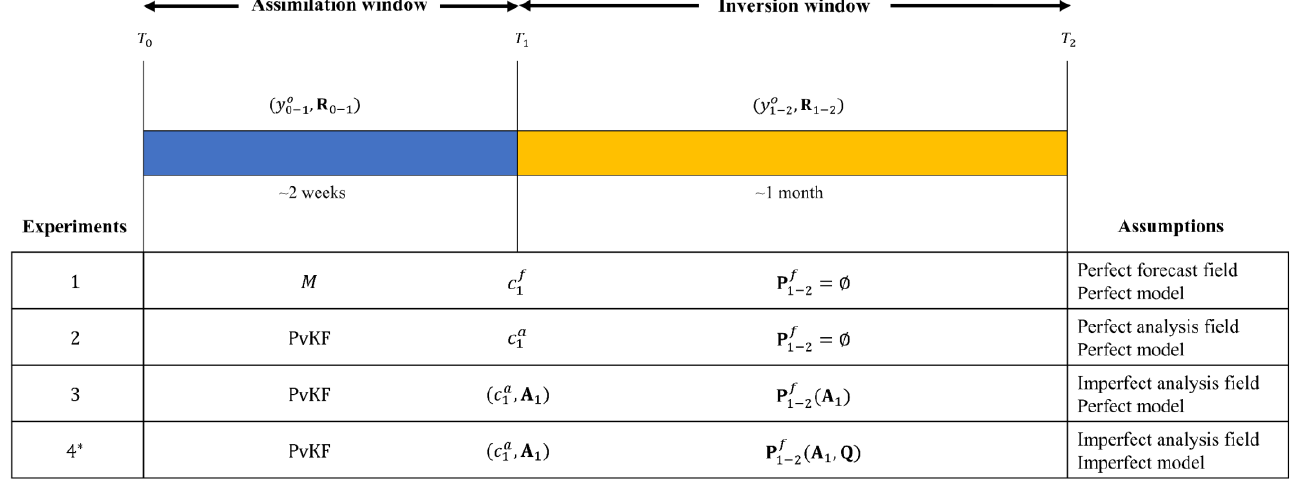
Figure 2. Sketch of the assimilation window in blue, followed by the inversion window in yellow, used in the proposed approach for estimating methane emissions. Depending on the assumptions, four types of experiments are shown to provide various initial fields and error covariances during the inversion window. * Experiment 4 represents what this study proposes and is equivalent to inversion Type 0 in Table 2. M denotes the CMAQ model and P f is model-propagated error covariance. As shown in the rest of Figure 1, four main types of experiments are designed to investigate the role of state concentrations and their uncertainties for emissions